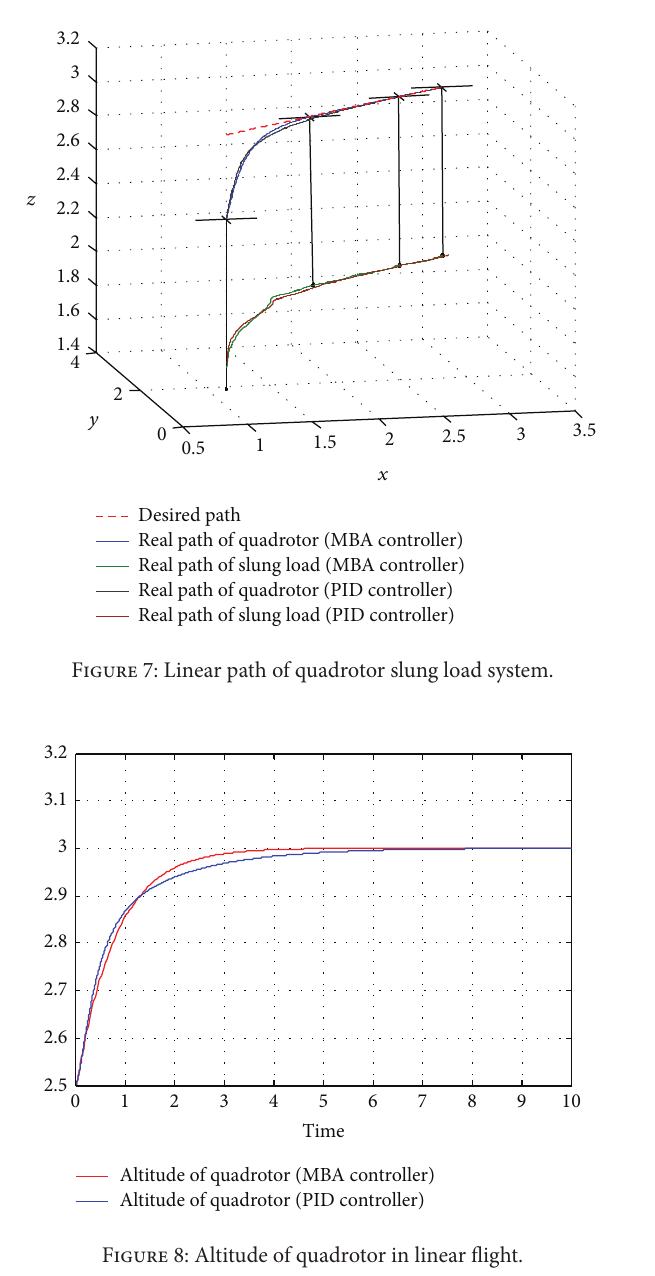
Figure 10: Circle path flight of quadrotor slung load